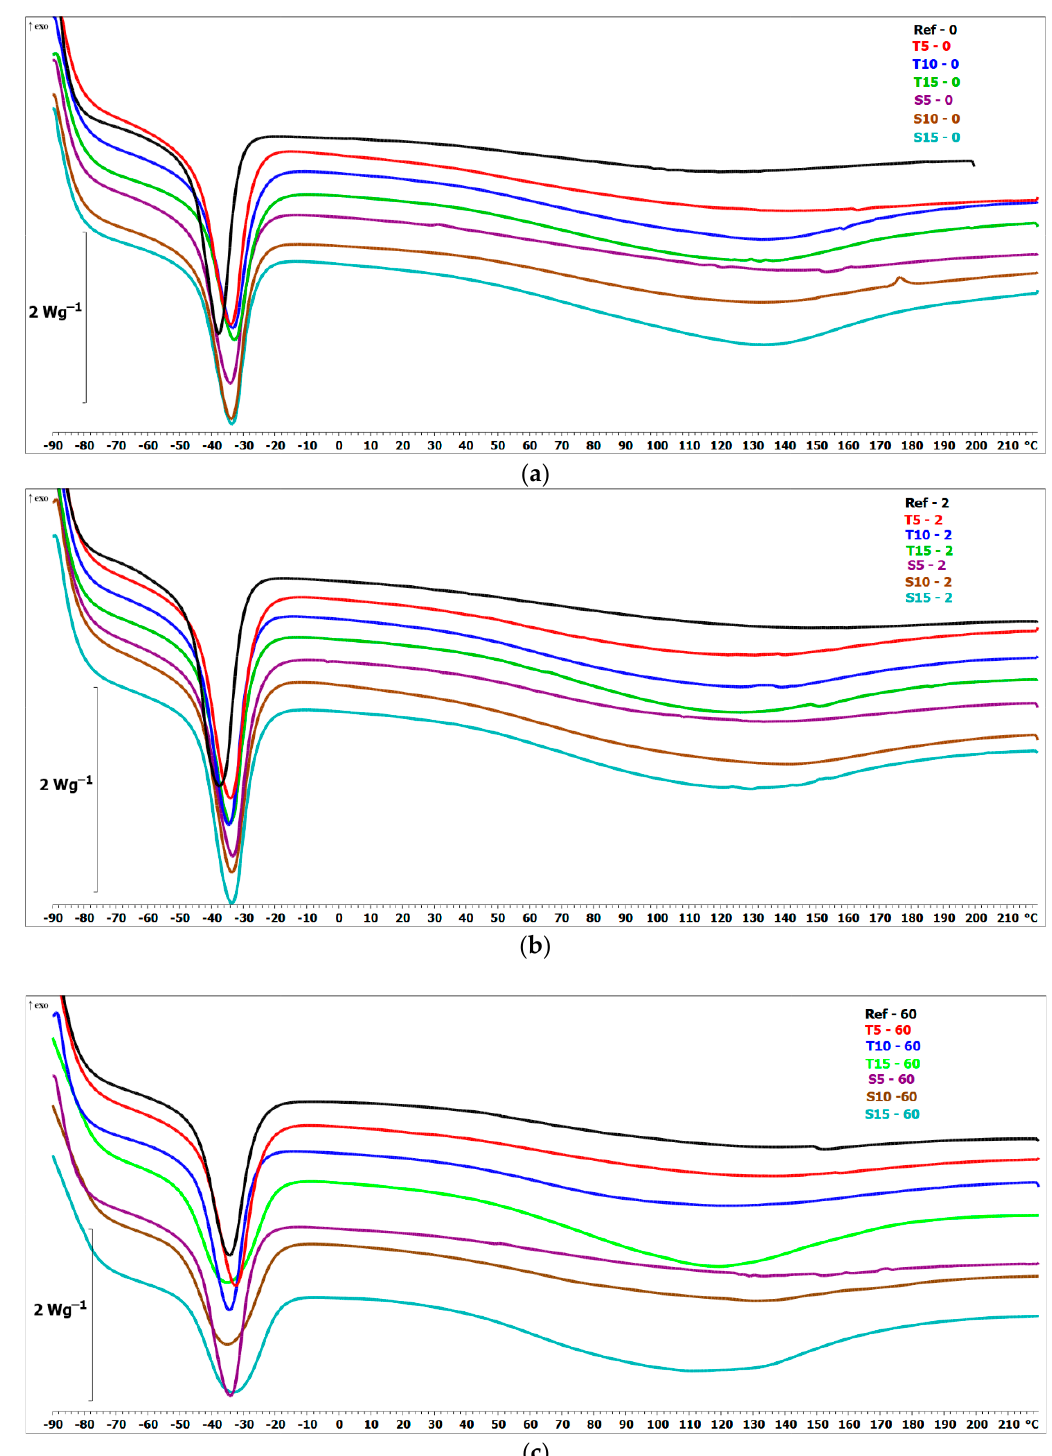
Figure 14. DSC heating thermograms of the tested materials: ( a ) native samples, ( b ) after 2 days of aging, ( c ) after 60 days of aging.